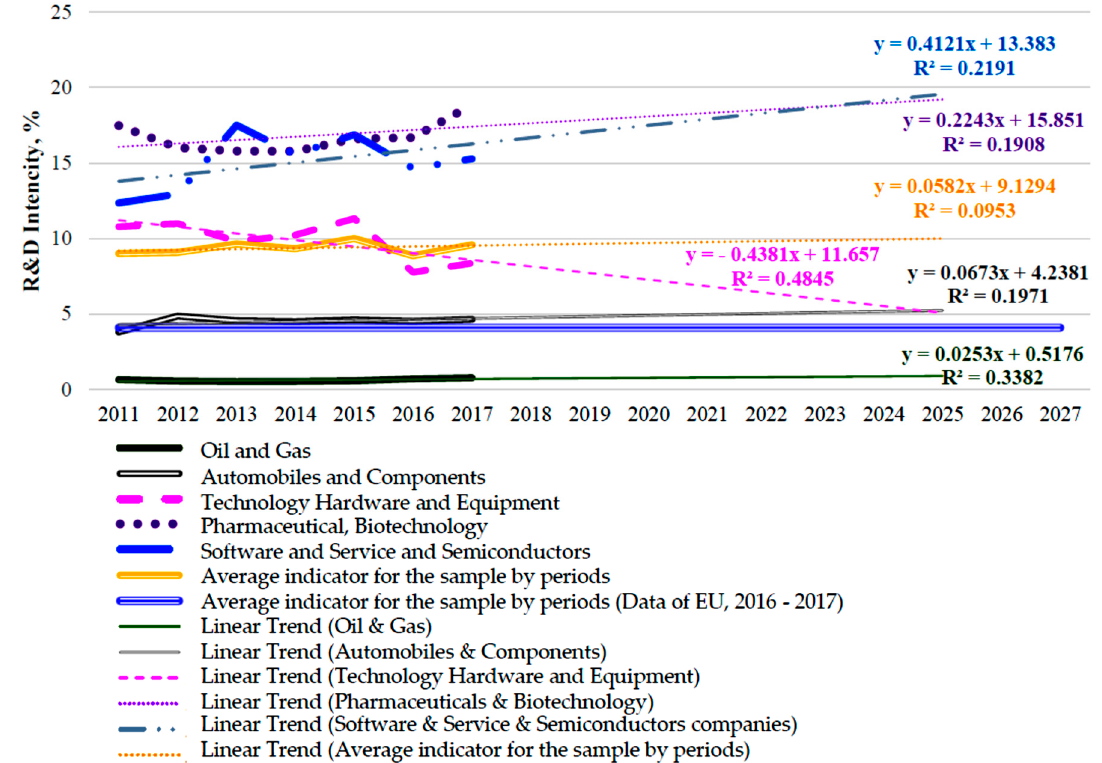
Figure 3. Forecast (building a linear trend) R&D intensity of Oil Companies in comparison with companies in other industries until 2025, %. Source: calc. by author by data [56].